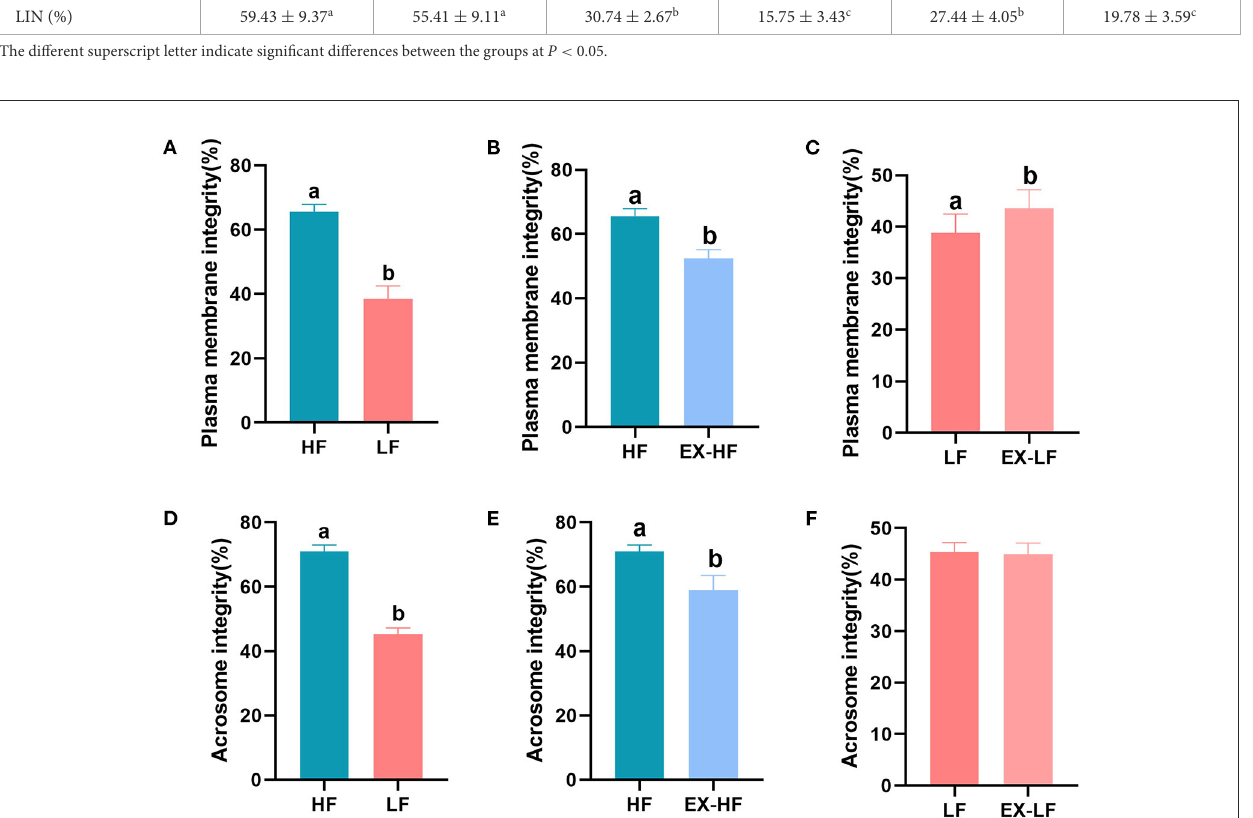
selected as differential metabolites, and metabolites with a VI P - value > 1 and P -value < 0.05 were selected as significant differential metabolites. Then, 38 discriminating differential metabolites were identified in seminal plasma, including 21 in the positive ion mode and 17 in the negative ion mode (Tables 2,